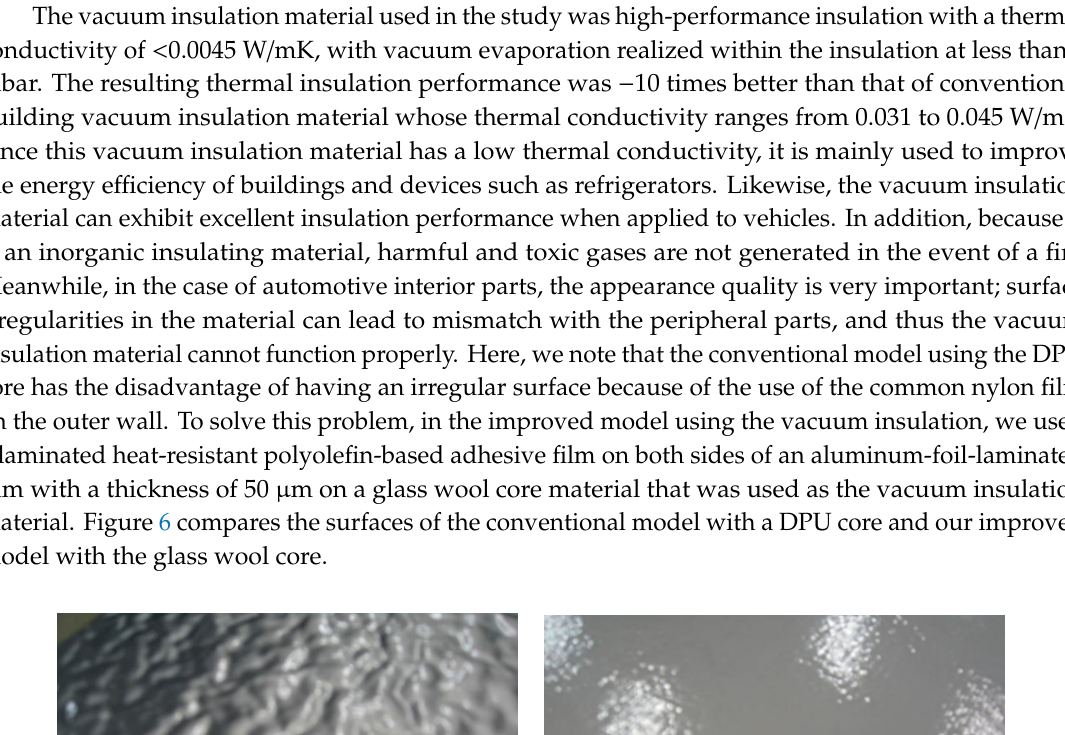
Figure 5. Thermal conductivity of dry polyurethane (DPU) material as function of temperature.